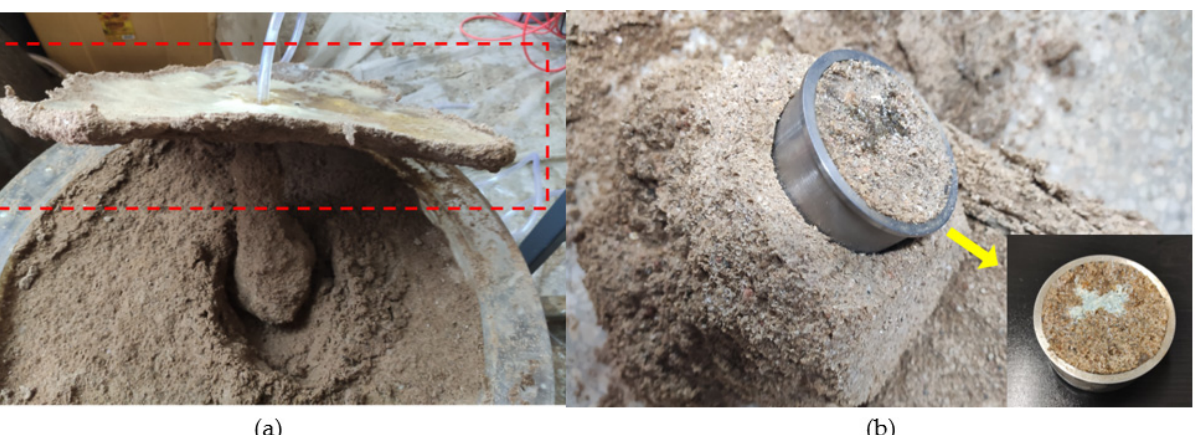
Figure 7. Test sand particle size gradation cumulative curve.